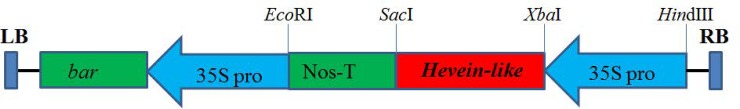
The fragments cloned of the plant expression vector-pCAMBIA3300-35S-hevein-like-NOS.